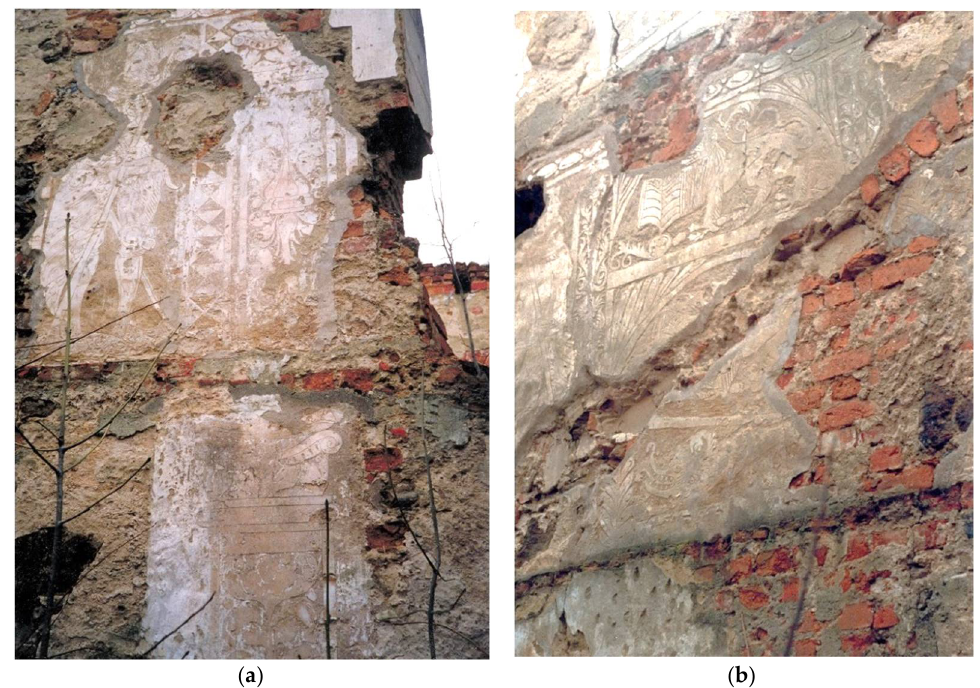
Figure 7. ( a , b ) Remains of sgraffito decorations on the elevations of the castle in Rudnica. Author’s photo, 2003.